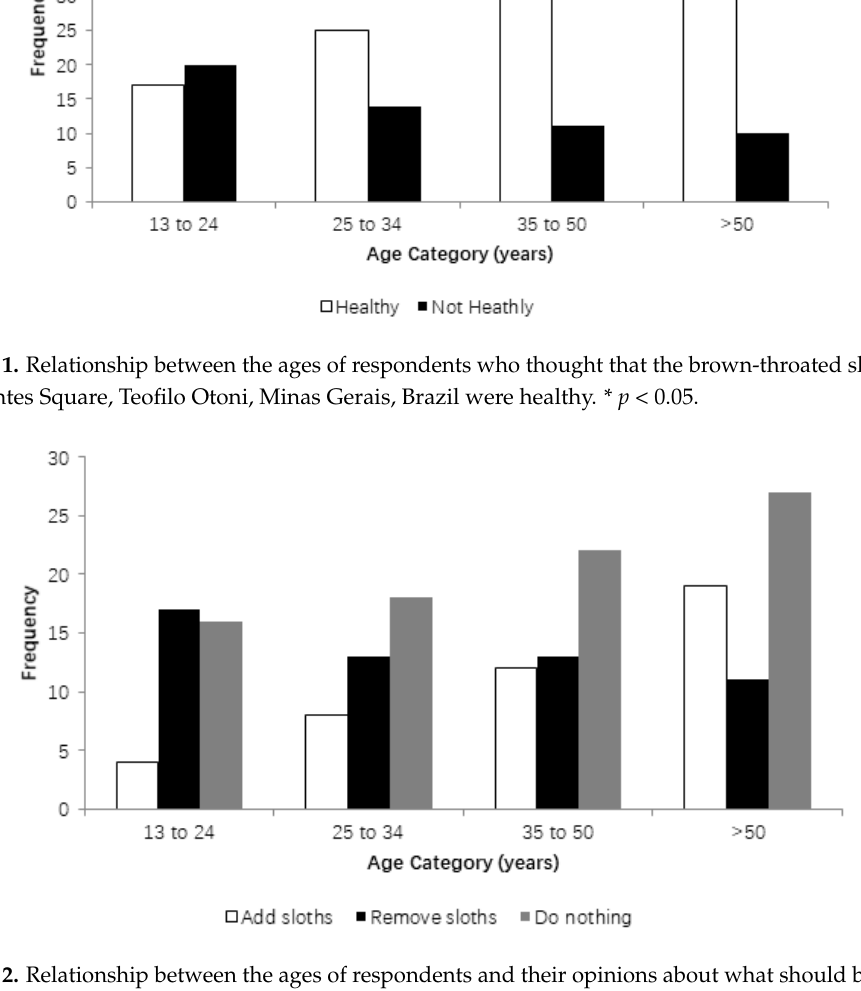
Figure 2. Relationship between the ages of respondents and their opinions about what should be done with the brown-throated sloths in Tiradentes Square, Teofilo Otoni, Minas Gerais, Brazil.